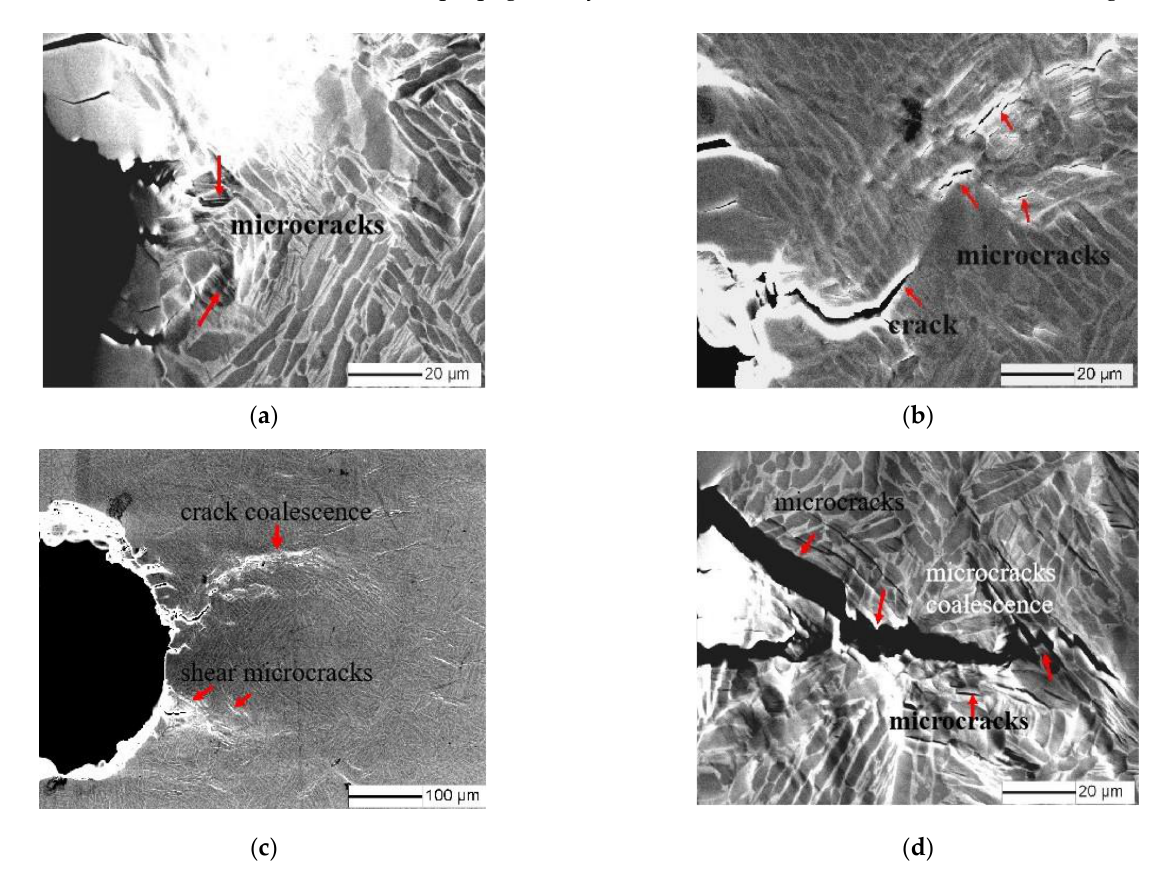
Figure 11 . Cracks propagation process under maximum load of 1800 N. ( a ) N = 25 cycles. ( b ) N = 180 cycles. ( c ) N = 250 cycles. ( d ) N = 350 cycles.